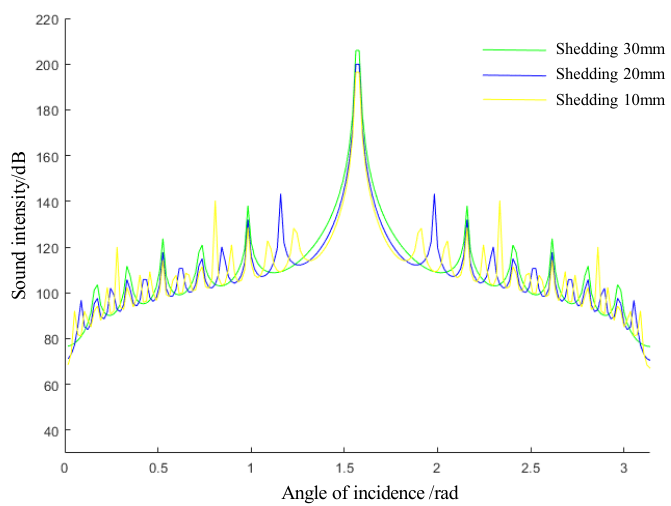
Figure 11. Sound intensity of rigid finite-length cylinder with shedding damage.